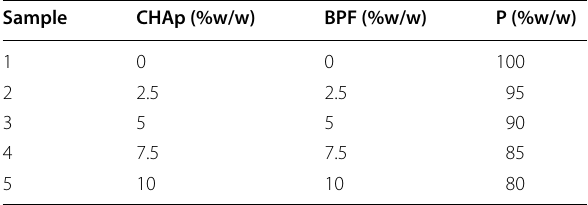
Table 1 Compositions of composites samples